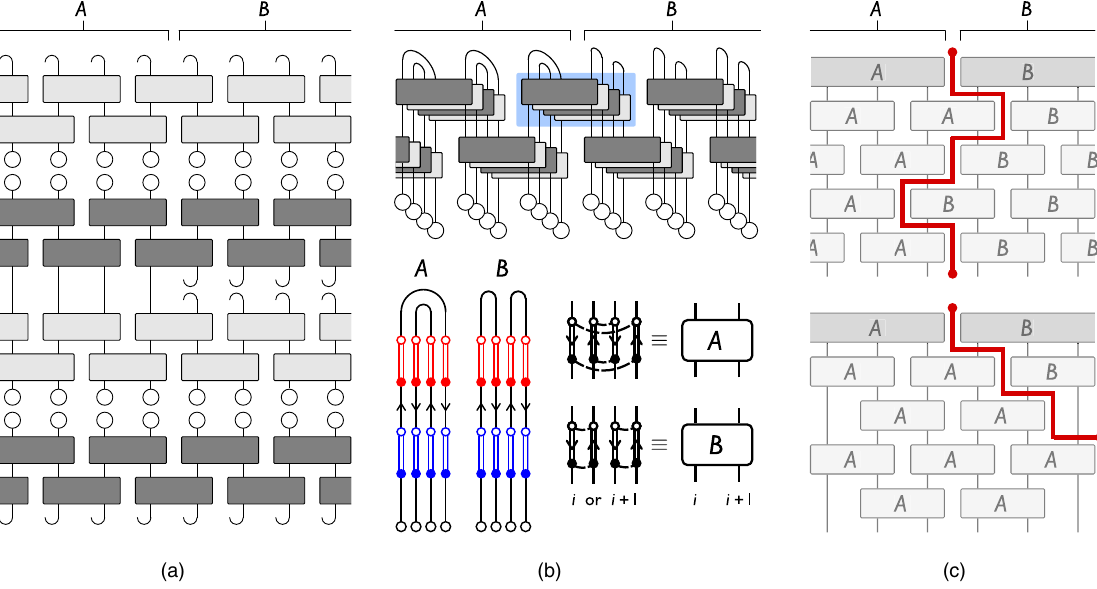
FIG. 9. Summary of the steps that convert the evaluation of the average purity into a combinatorial statistical mechanics problem. (a) Illustration of e − S 2 ð t Þ for t ¼ 1 . Open circles represent a product state in the site basis and other conventions are as in Fig. 2. (b) Top: Folded representation of exp ½ − S 2 ð t Þ(cid:2) obtained by folding (a) so that timelines in W ð t Þ run upward and those in W † ð t Þ run downward. The large blue box highlights a stack of four unitary operators (see main text). (b) Bottom left: Site diagrams in regions A and B . Note in particular how the timelines of sites in the regions A and B connect differently at the top of these diagram because of the structure of traces in Eq. (9). (b) Bottom right: The two possible local contractions made within a block, which we label A and B . Only leading-order diagrams have such contractions. We represent these contractions in two alternative ways: either explicitly for a single site, as on the left side of the equivalences, or schematically for a pair of sites and a stack of unitaries, as on the right side of the equivalences. Note that the top boundary of the diagram can be treated as equivalent to blocks of such contractions. (c) Leading-order diagrams for h e − S 2 ð t Þ i at large q are minimal-length domain-wall (DW) diagrams. Their weight is q − h AB with h A and B AB being the length of horizontal DW between contractions. The labels A and B on blocks in this figure indicate the type of local contraction. Top: A minimal-length DW diagram for h exp ½ − S 2 ð t Þ(cid:2)i at t ¼ 4 and L > 6 . Bottom: One of the two minimal-length DW diagrams at t > 2 and L ¼ 6 . These two diagrams have the DW directed solely to the left or